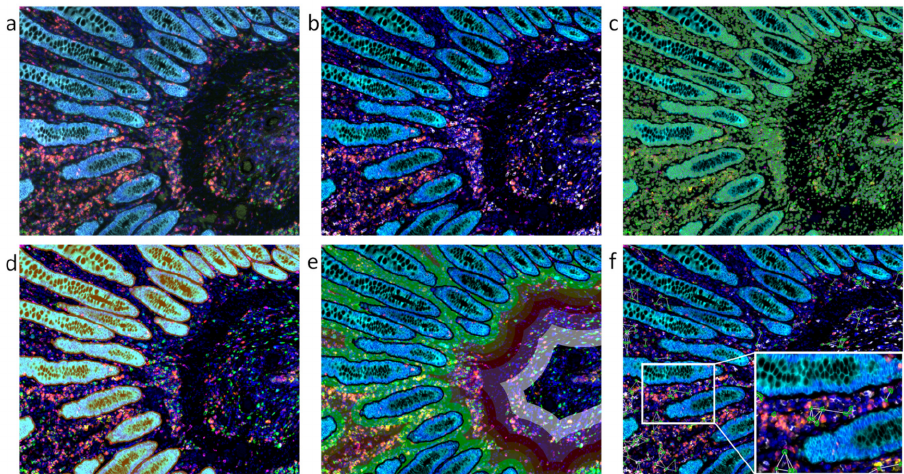
Figure 1. A representative example of high-dimensional automated tissue cytometry shown on a colon sample stained for seven markers. ( a ) Original multicolor immunofluorescence image data set acquired by a multispectral imaging technology. Nuclei stained by 4 (cid:48) ,6-diamidino-2-phenylindole (DAPI) in blue; immune markers/immune checkpoint markers CD4 in green/PD-L1 in yellow/PD1 in red/CD68 in pink/CD8 in orange; pan-cytokeratin marker in turquoise. As this raw data image contains overlapping emission signals from the fluorochromes, the colors appear mixed. ( b ) Image with clearly separated fluorescent signals obtained by a mathematical procedure referred to as spectral unmixing. ( c ) Nuclei detection, highlighted by the green contour mask shown in overlay to the original image. ( d ) Metastructure detection of epithelial cells, highlighted in orange overlay. ( e ) Proximity measurements in relation to detected metastructures with various distance zones highlighted by different colors. ( f ) Analysis of spatial connections among and between single cells of a specific cellular phenotype highlighted by a green mask and white connecting lines. The images were provided by and analyzed using TissueGnostics’ image cytometry solution